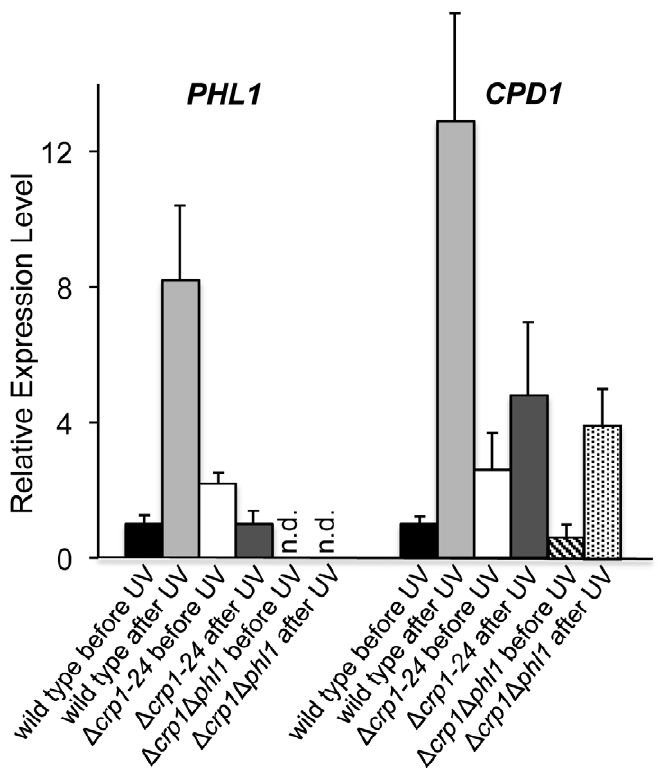
Figure 10. Regulation of genes involved in photoreactivation by CRP1 . After exposure to UV light, cultures were incubated under white-light condition for 1 h to promote photoreactivation. The experiments were performed with three biological replicates, and two independent experiments produced similar results.